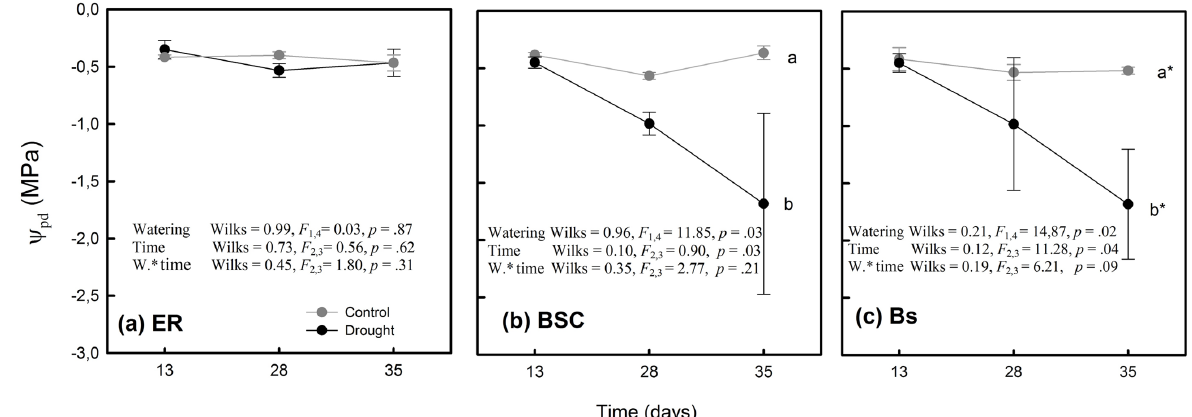
Figure 4. Predawn water potential ( (cid:57) pd ) values for Nothofagus pumilio seedlings grown in different soil cover types and under conditions of full and restricted watering (control and drought, respectively). ER, soil covered by Empetrum rubrum ; BSC, soil covered by biological soil crust; and Bs, bare soil. Values are the means of three replicates per treatment ± standard error. Significance values ( p ) are from one-way, repeated-measures ANOVAs testing the effects of watering regime over time. Wilks indicates the Wilks’ lambda value.